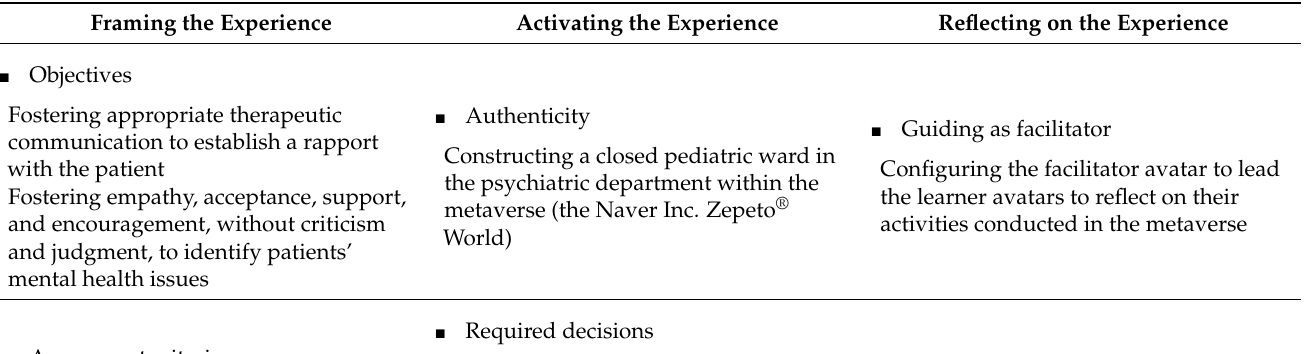
Table 1. Multi-access metaverse-based early onset schizophrenia nursing simulation program using Lindsey and Berger’s [18] experiential approach to an instructional